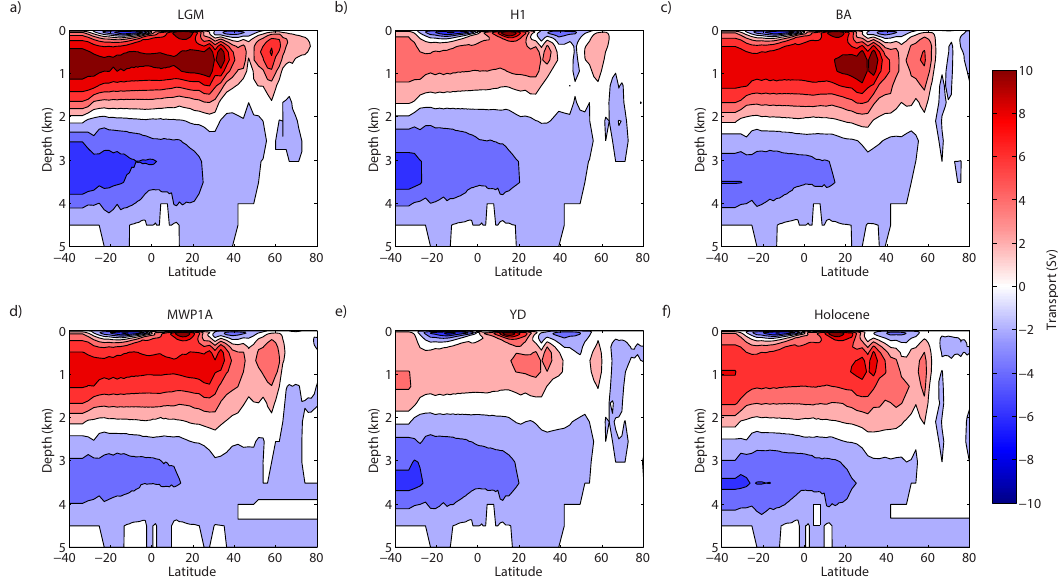
Figure 4. Overturning function averaged for each period: (a) LGM (22ka–19ka); (b) H1 (19ka–14.67ka); (c) BA (14.67ka–14.35ka); (d) MWP-1A (14.35ka–13.85ka); (e) YD (12.9ka–11.3ka); (f) Holocene (11.3ka–0ka). The colors represent transport, in Sverdrup.